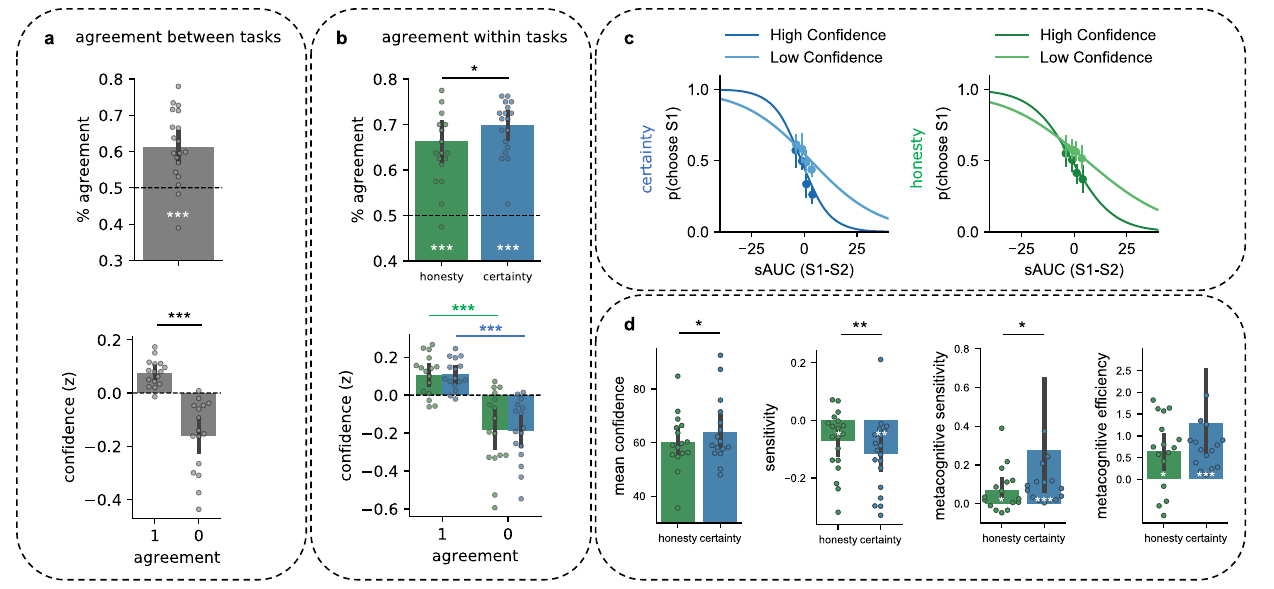
Fig. 2 Stability and precision of the perceptual decisions made in the two tasks. a Top: percentage of agreement across the two tasks (computed as the percentage of trials in which stimuli were classi fi ed similarly: voices classi fi ed as certain and honest versus doubting and lying correspond to an agreement). White asterisks show the signi fi cance of the result of the two-sided t test comparing the percentage of agreement between tasks with chance level (50%) and reported in the main text, with *** corresponding to p < 0.001. Bottom: normalized ( z -scored) con fi dence ratings averaged separately for agreements and disagreements. Black asterisk shows the result of the two-sided t test comparing con fi dence for agreements versus disagreements reported in the main text, with *** corresponding to p < 0.001. Data are presented as mean values with error bars showing the 95% con fi dence interval. Dots show individual data. b Top: percentage of agreement within each task, computed as the percentage of double-pass trials in which stimuli were classi fi ed similarly. White asterisks show the signi fi cance of the result of the two-sided t test comparing the percentage of agreement within each task with chance level (50%) reported in the main text, with *** corresponding to p < 0.001. The black asterisk shows the results of the two-sided t test comparing the two tasks reported in the main text; * p = 0.02. Bottom: con fi dence ratings depending on agreement in the honesty (green) and certainty (blue) tasks. Green (honesty task) and blue (certainty task) asterisks show the result of the two-sided t test comparing con fi dence for agreements versus disagreements within each task, with *** corresponding to p < 0.001. Data are presented as mean values with error bars showing the 95% con fi dence interval. Dots show individual data. c Probability of responding that the fi rst voice ( p (choose S1)) sounds more certain (left, blue) or honest (right, green) as a function of the area under the curve computed by subtracting sensory evidence for the fi rst minus the second stimuli, summed for the three acoustic dimensions. Darker lines correspond to high con fi dence trials (above the median) and lighter lines to low con fi dence trials (below the median). Circles show mean values and error bars the 95% con fi dence interval. d Average con fi dence, sensitivity, metacognitive sensitivity, and ef fi ciency in the honesty and certainty tasks. Data represent mean values with error bars showing the 95% con fi dence interval, and dots show the individual data; black asterisks show the result of the two-sided tests comparing the two tasks, and white asterisks show the results of two-sided tests against chance level; t tests were used for con fi dence (normally distributed data), and Wilcoxon signed-rank tests for sensitivity, metacognitive sensitivity, and ef fi ciency (non-normal data); * p < 0.05; ** p < 0.01; *** p < 0.001; con fi dence: p values for the comparison between tasks p = 0.037; sensitivity: p values testing the difference with chance level, for certainty p = 0.0011/honesty, p = 0.012; comparison between tasks, p = 0.01; metacognitive sensitivity (0.0004/0.034/0.026); metacognitive ef fi ciency (0.0004/0.01/0.72). Source data are provided as a Source data fi